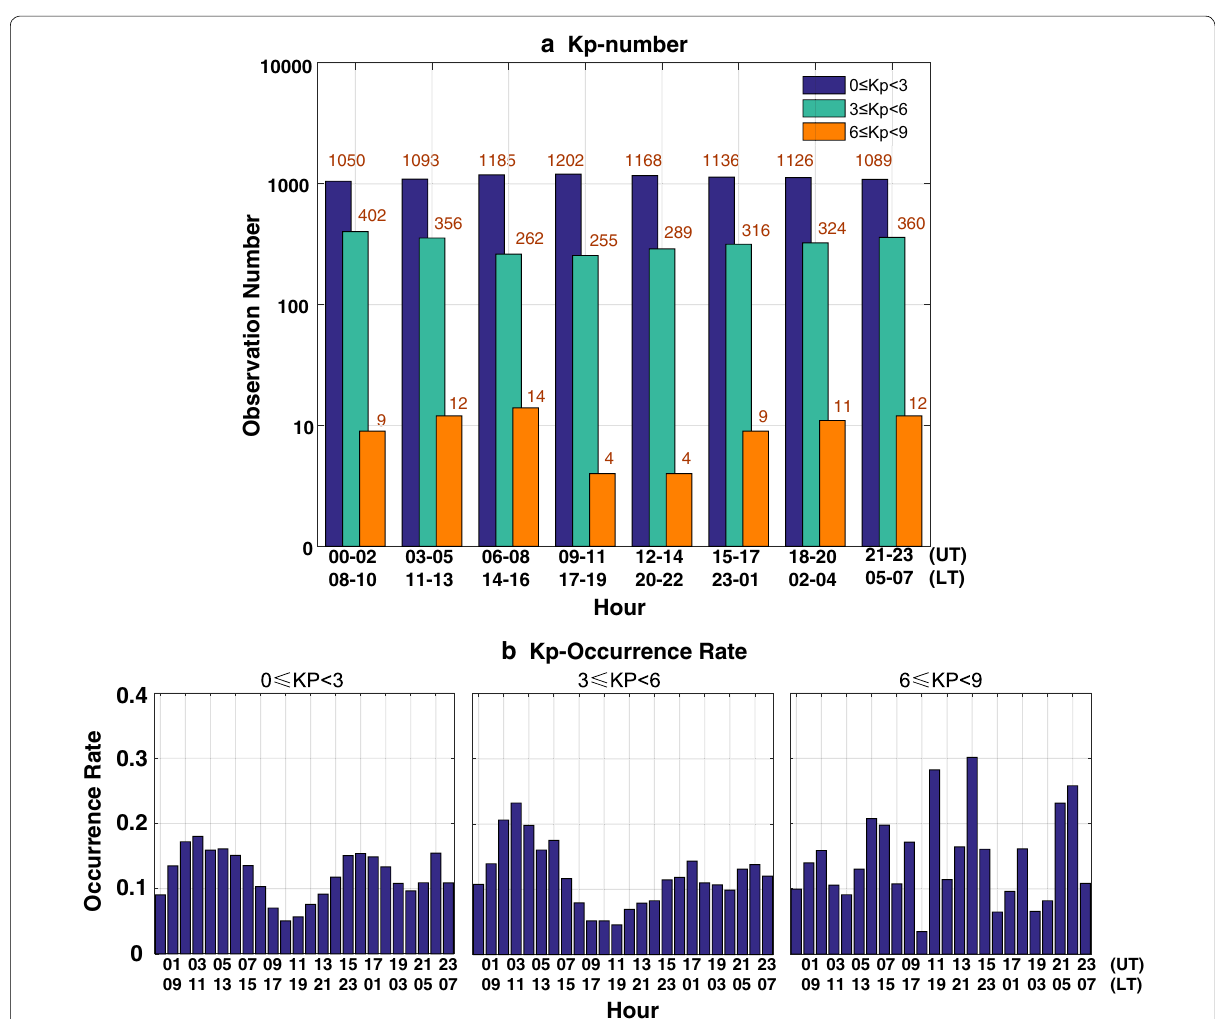
Fig. 6 The total observation number and occurrence rate of MSTIDs as a function of the LT distribution under different geomagnetic activity